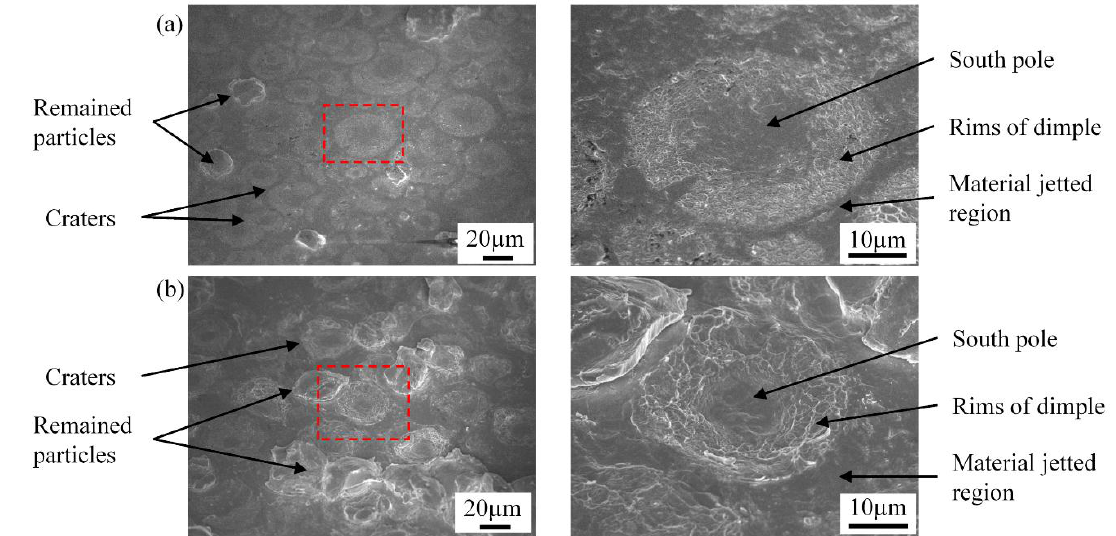
Figure 9. SEM micrographs of fractured interfaces on the substrate side for the coatings deposited at particle velocities of ( a ) 730 and ( b ) 855 m/s, observed under different magnifications at a tilted angle of 45 ◦ . The fractured interfaces of the other velocities are shown in Figure S1 (Supplementary